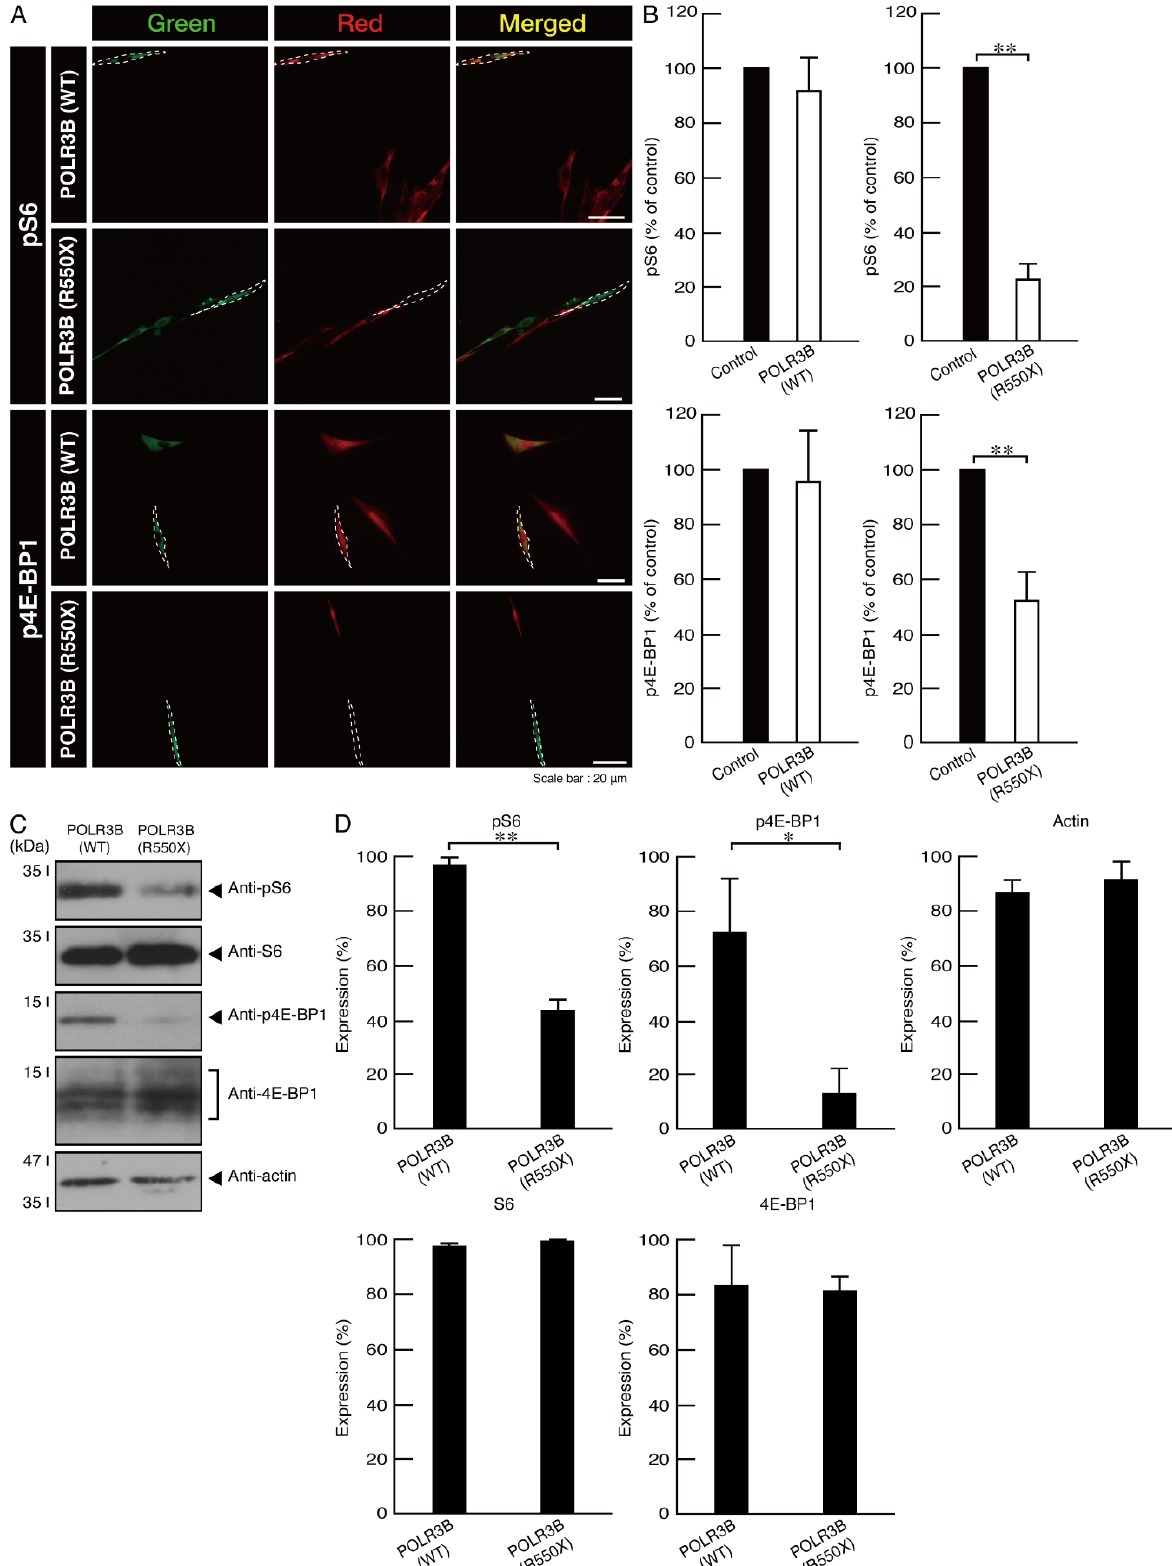
Figure 10. Cells harboring the mutants decrease phosphorylation levels of ribosomal S6 and 4E-BP1 proteins at the cell and protein levels. ( A , B ) Cells harboring the wild type (WT) or POLR3B (R550X) (green) were stained with an anti-(pS240 and pS244)ribosomal S6 protein (pS6) or